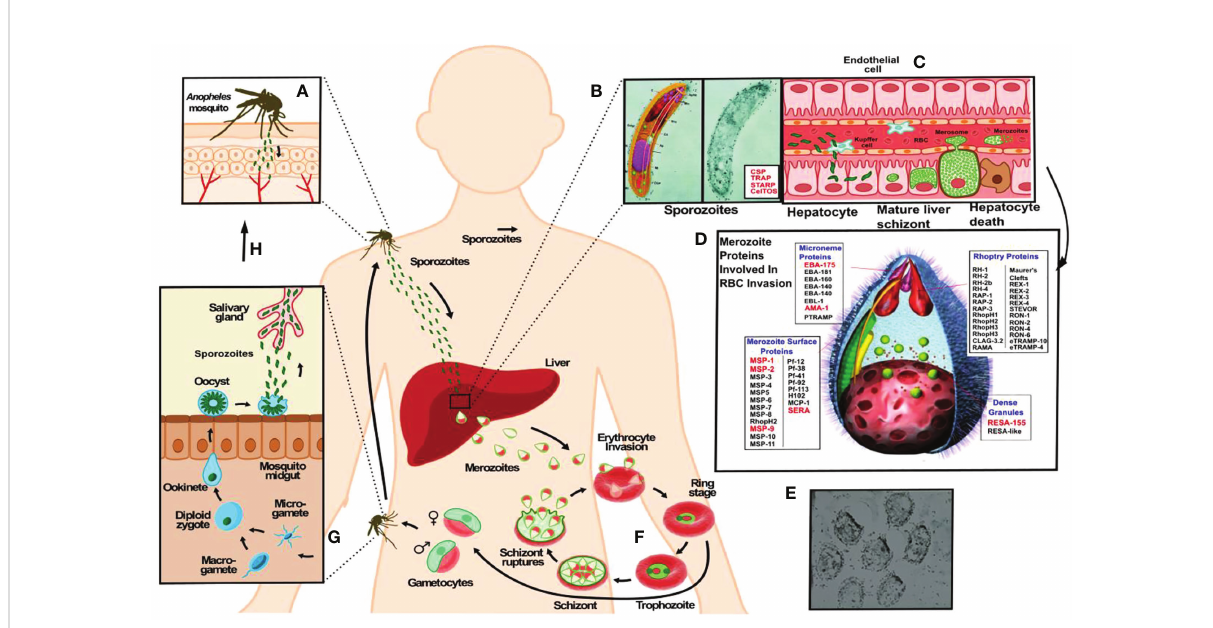
FIGURE 1 The P. falciparum malarial parasite has two infective forms regarding its human host. A female Anopheles mosquito injects (A) a larvae-like structure or sporozoite (Spz) (B) during her blood meal (<1,000 Spz/bite). These migrate to the liver to infect hepatic cells where each reproduces ~30,000 times during a single week (C) , changing their morphology and molecules to yield the second infective form: the merozoite (Mrz). This is a pear-like structure (D, E) which invades red blood cells (RBCs) where it reproduces ~32-50 times each 48 hours (F) to infect an equal number of RBC, thereby producing the clinical symptoms of this disease: episodes of very high fever followed by chills, headache, nausea, vomiting, malaise, abdominal and muscle pain, anaemia, cerebral and renal malaria. The latter leads to the death of sick patients when not properly and/or opportunely treated. Another stage consists of gametes (G) (male and female) infecting a new mosquito (H) , thereby continuing the reproductive cycle to infect other human beings (A)